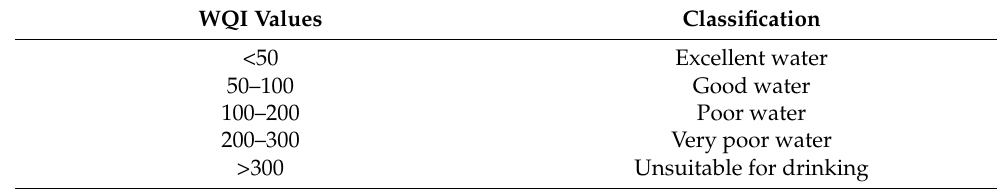
Table 3. Classification of WQI